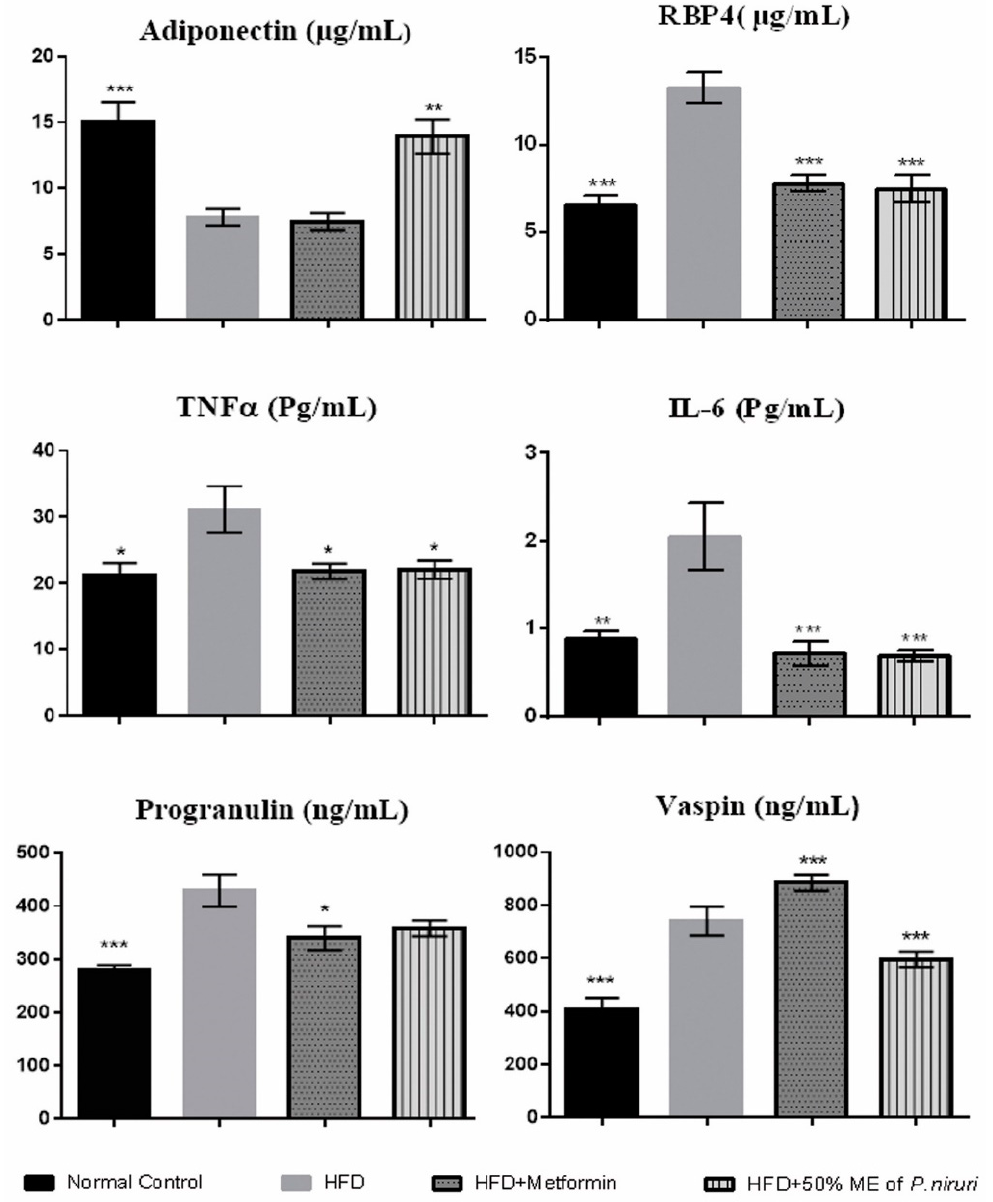
Figure 2. Effects of P. niruri on adiponectin, RBP4, TNF α , IL-6, progranulin, and vaspin in the different groups. * p < 0.05 vs. HFD group, ** p < 0.01 vs. HFD group, *** p < 0.001. Data expressed as mean ±